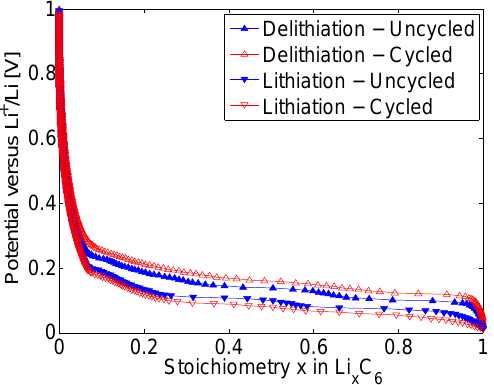
Figure 4. Uncycled and cycled Graphite equilibrium potential versus